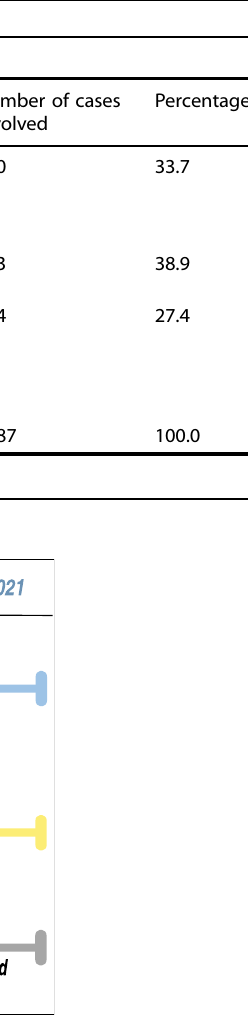
Fig. 3 Acquisition sources of statistical data from 2012 to 2021. The timeline columns show the records of of fi cial data and news sources during the corresponding time